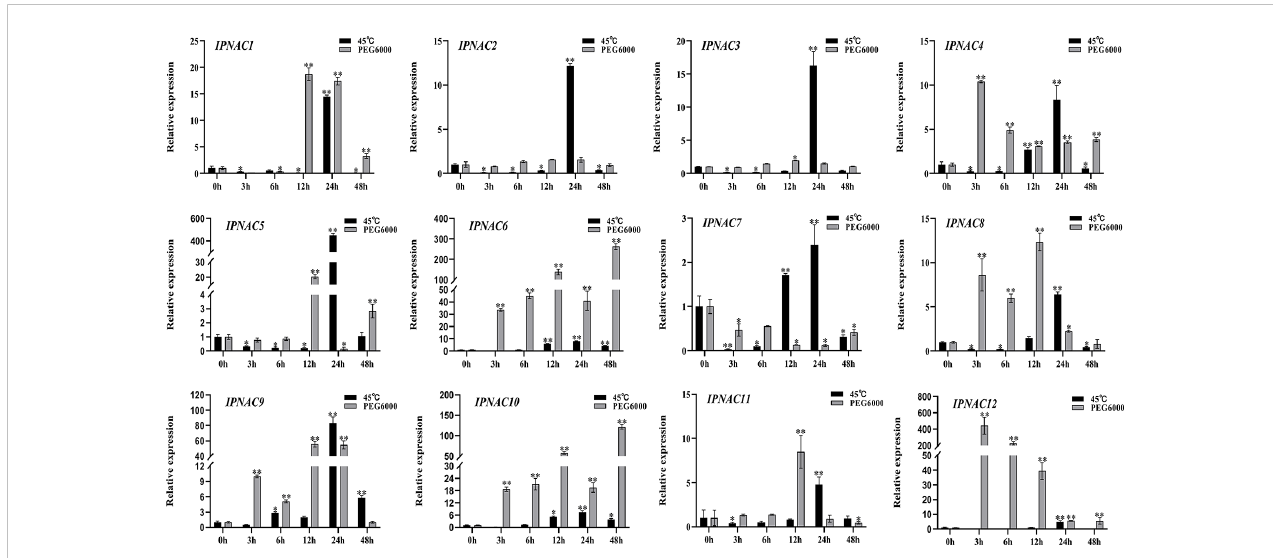
FIGURE 5 The expression level of IpNAC genes under heat (45 °C) and 20% PEG 6000 solution stress treatments. The roots were soaked in 20% PEG 6000 solutions and collected at different time points (0, 3, 6, 12, 24, and 48 h). Non-stressed plants (0 h) were used as a control, and each experiment was conducted with three biological replicates and three technical replicates. The mean values and SD were obtained from the experiment. The p-values were evaluated using Student ’ s t -test. Asterisks indicate the level of signi fi cance, ** p < 0.01 and * 0.01 < p < 0.05 . Transcript levels at 0 h were set as